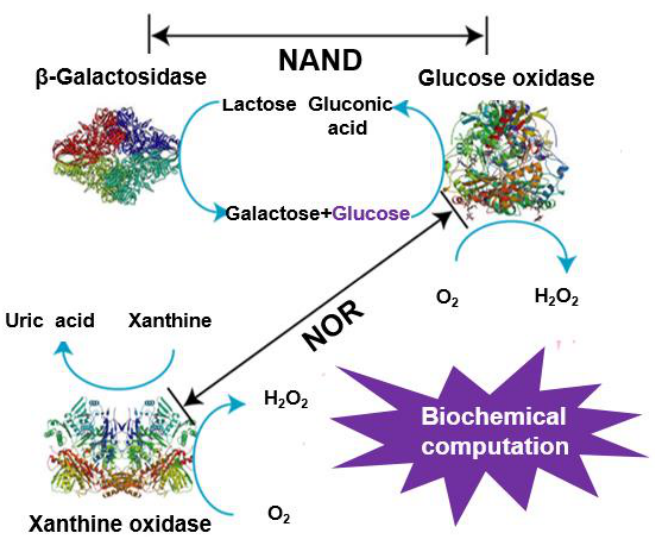
Figure 4. ( a ) Absorbance intensity at 652 nm of TMB reaction solutions in the presence of (from left to right): no reactants, glucose, GOx, glucose/GOx. ( b ) Absorbance intensity at 652 nm of TMB/GOx reaction solutions in the presence of (from left to right): no reactants, lactose, sucrose, maltose, fructose, and glucose. ( c ) Typical photographs of oxTMB reaction solutions reacting with NaBH 4 , glucose/GOx, and cysteine, respectively. ([TMB] = 120 µ M, [CeO 2 NPs] = 4 µ g/mL, [glucose] = 5 mM, [GOx] = 1 unit/mL, [citrate buffer] = 40 mM, pH 6.0).